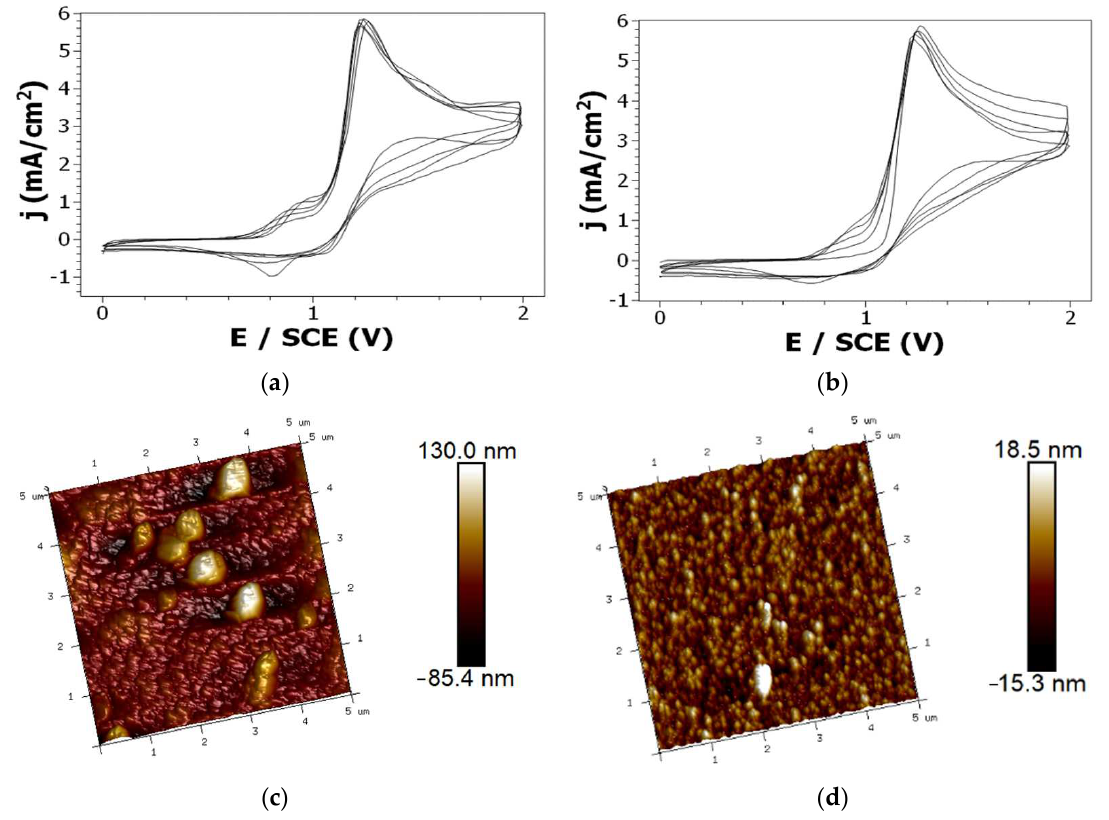
Figure 8. Cyclic voltammograms obtained by oxidation of: 10:90 Cz:CzA ( a ) or 5:95 Cz:CzA ( b ) in an acetonitrile + 0.1 M LiClO 4 solution (WE: Pt. Scan rate: 50 mV/s) and 3D morphology AFM pictures of the polymer films resulting from the electro-oxidation of 10:90 Cz:CzA ( c ) or 5:95 Cz:CzA ( d ) solutions.